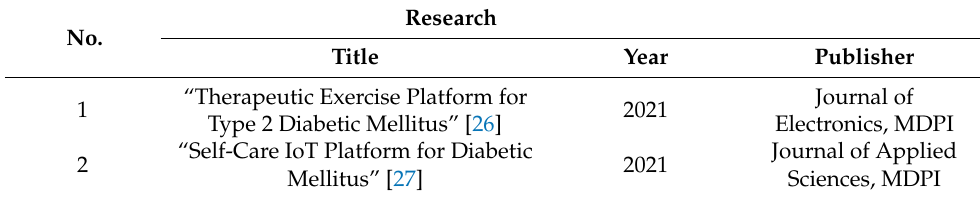
Table 2. Previous Research.